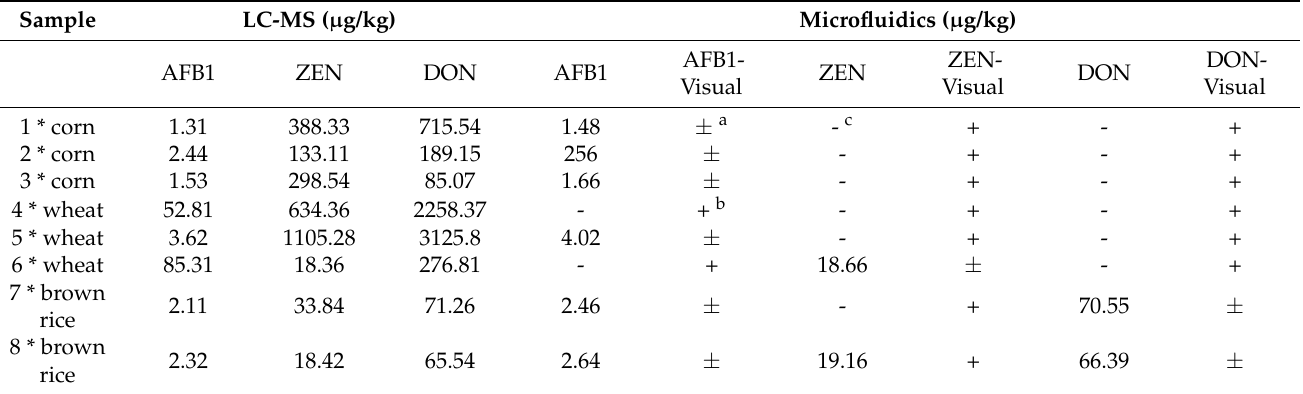
Table 4. Naturally sample analysis with Microfluidics ( n =